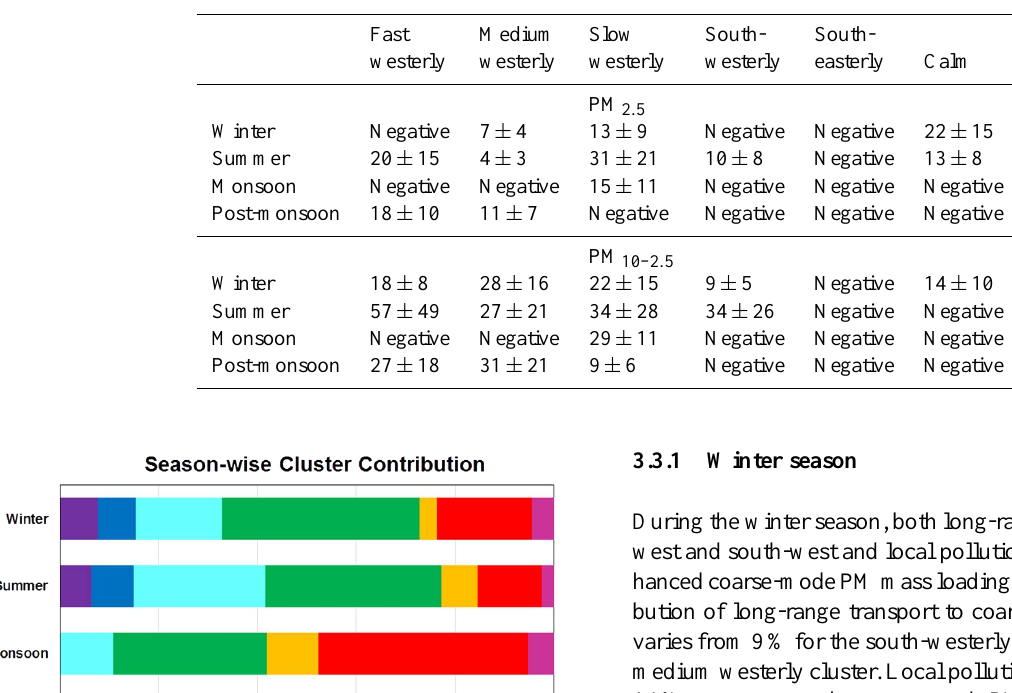
Table 2. Lower limit for the contribution of long-range transport and local pollution events to PM mass loadings in % ± 1 σ of the total PM. “Negative” indicates that the PM mass loadings are not enhanced compared to the local cluster, which represent the regional background levels.